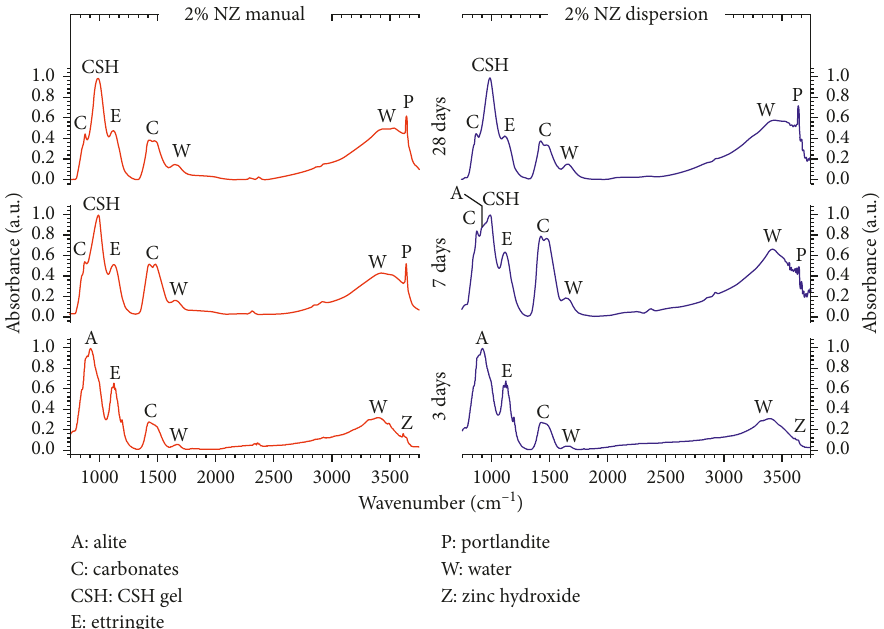
Figure 2: FTIR analysis for cement paste with 2 wt.% of nanozinc